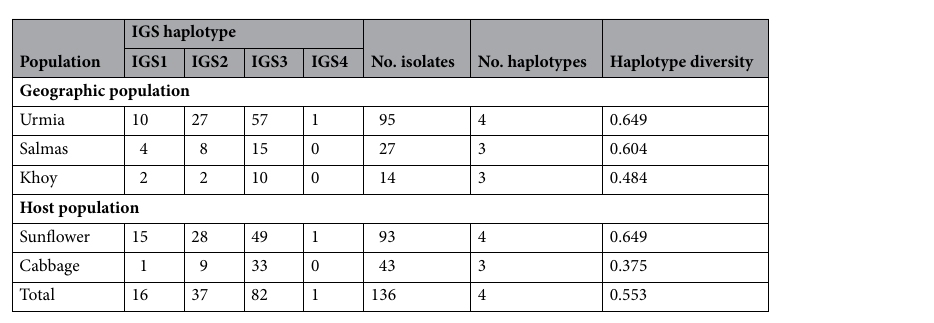
Table 3. Frequency and diversity of IGS haplotypes of Sclerotinia sclerotiorum isolates in geographic and host populations.